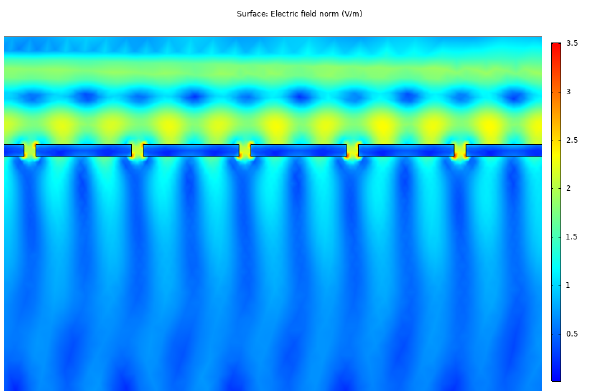
Figure 15. Local field amplification in the nanoantenna apertures for gold array.